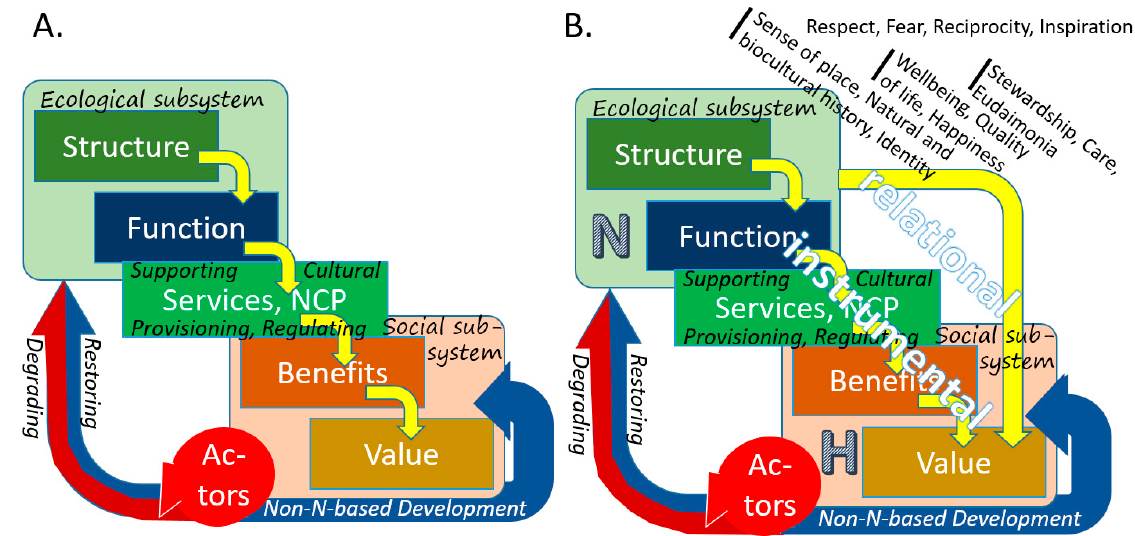
Figure 5. ( A ). The ecosystem cascade concept of ecological–social systems, with ecosystem services (alternatively described as nature’s contributions to people or NCPs) at the interface of the two subsystems and feedback by human actors using, degrading, and/or restoring the ecological subsystem; ( B ). Distinction between instrumental (goal-oriented) values of nature and relational values that are not dependent on material benefits.